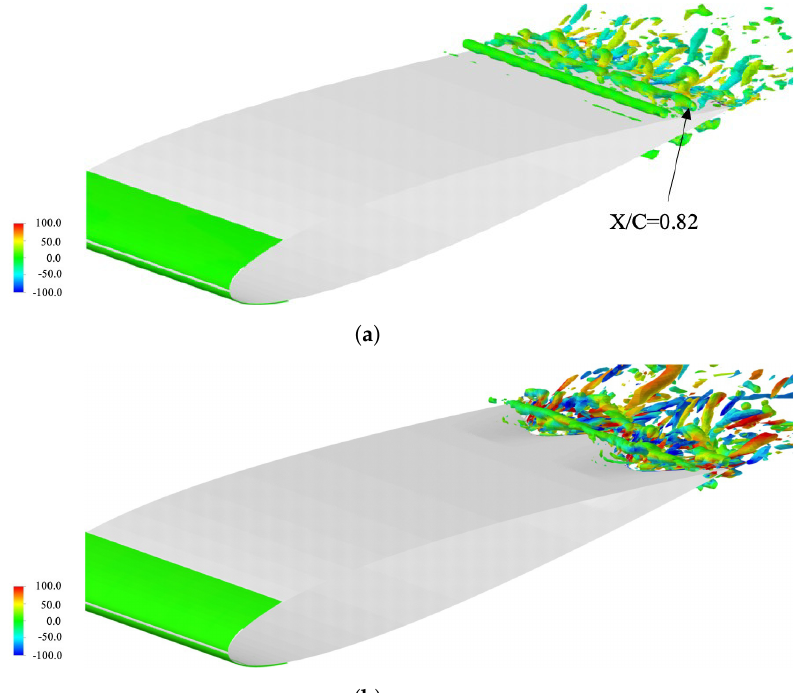
Figure 7. Instantaneous profile of iso-contours of Q = 400 colored by | ω x | ≤ 100: ( a ) NACA0012 airfoil; and ( b ) serrated